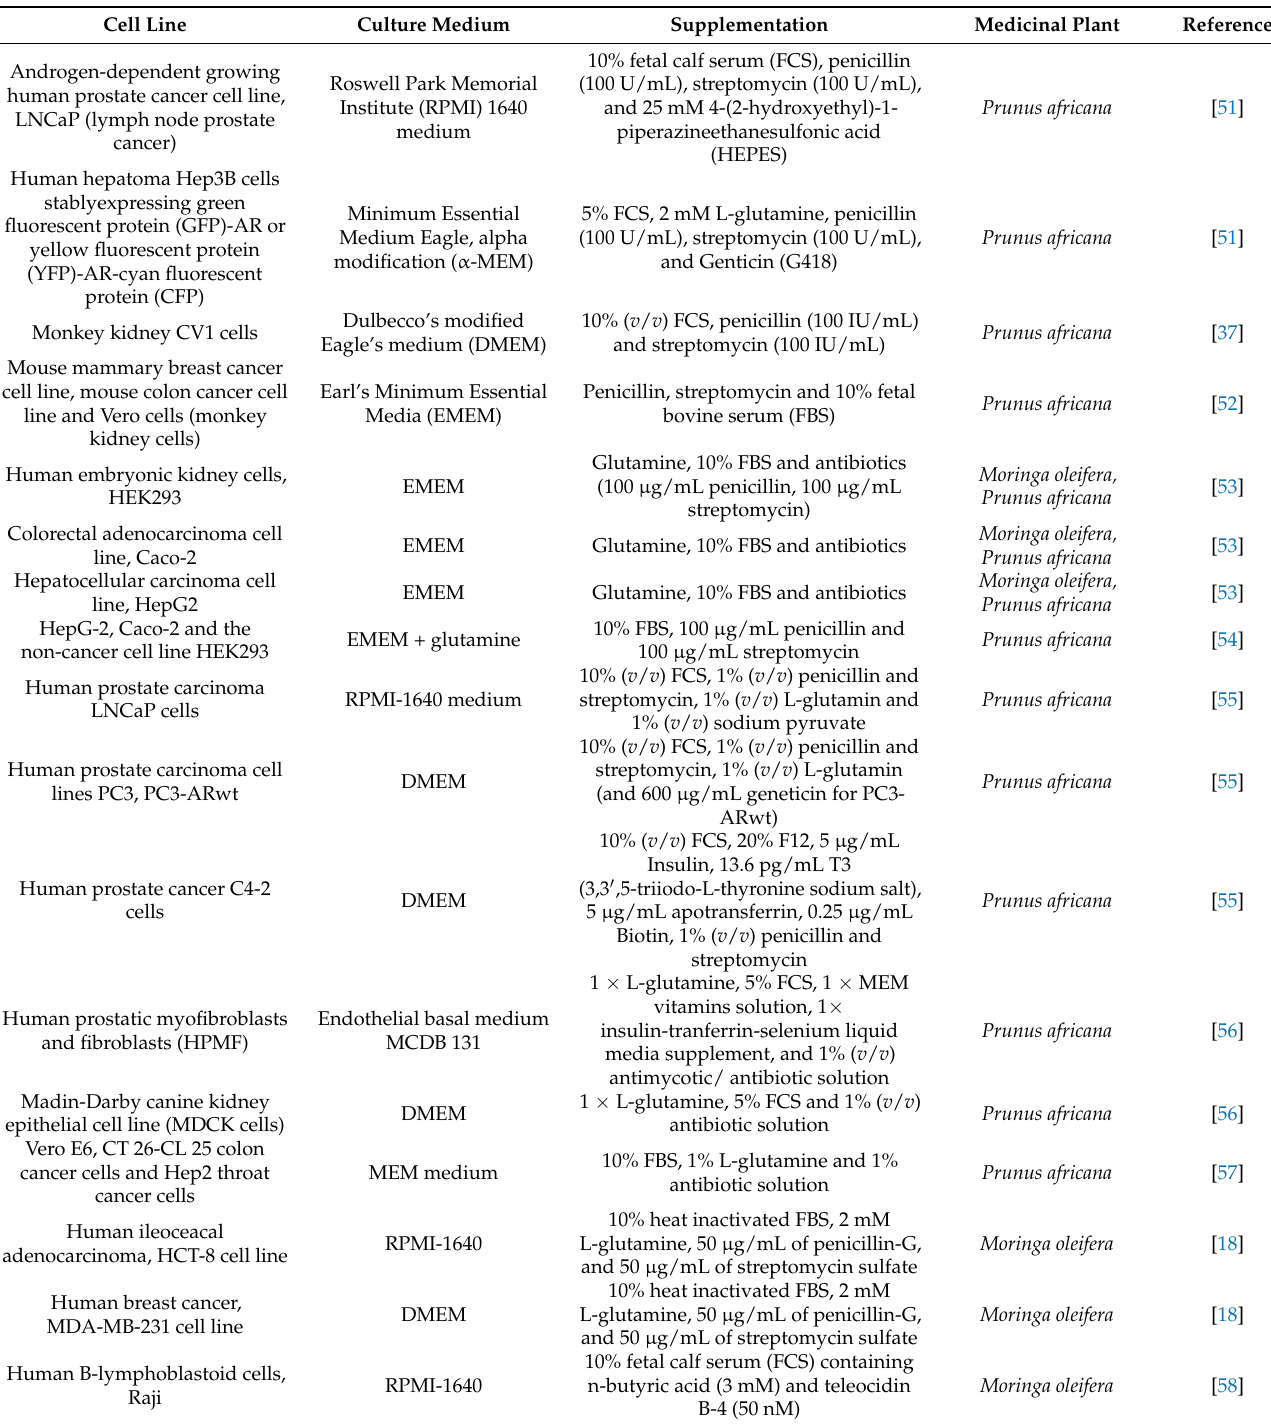
Table 1. Some cell lines used in determining anticancer potential of selected medicinal